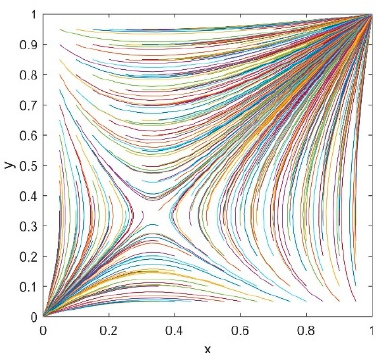
Figure 5. Evolution of the integrated strategy in Case 1.